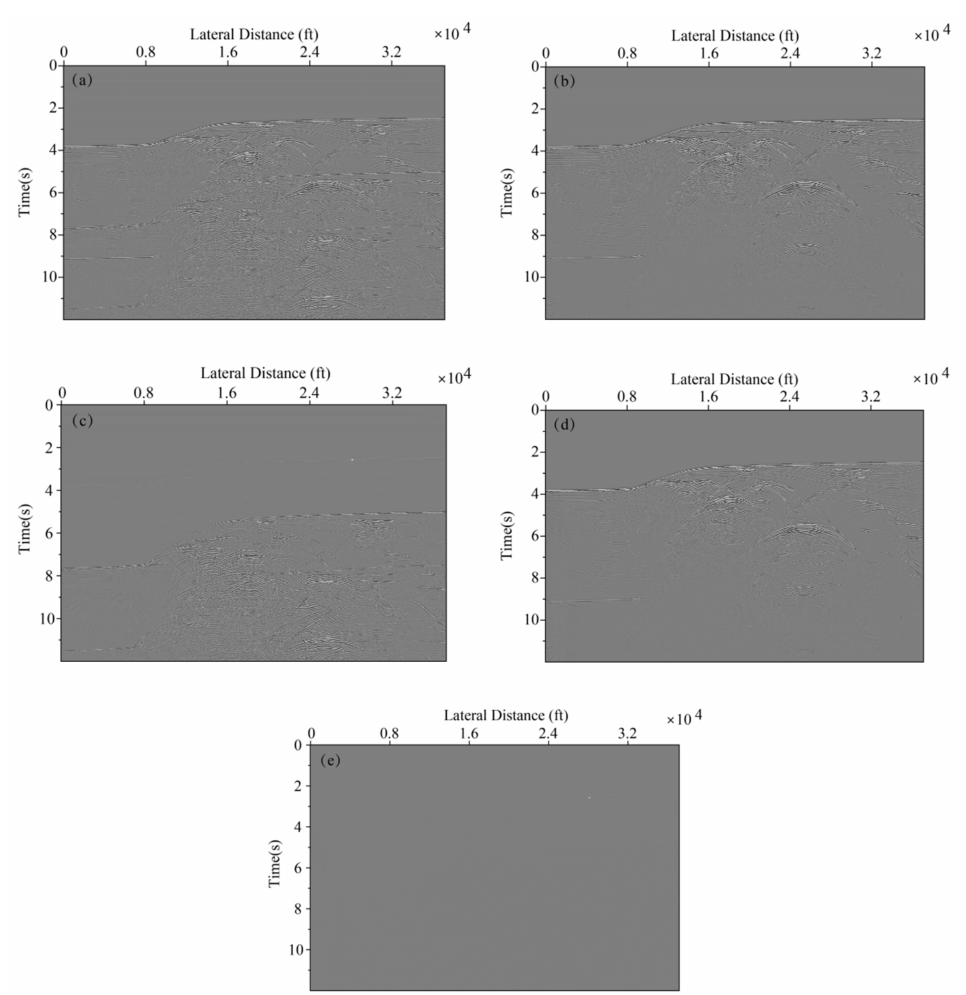
Figure 8. Zero-offset data with surface-related multiple elimination using deep learning. ( a ) Original zero-offset data with surface-related multiples. ( b ) Result after using deep learning. ( c ) The predicted internal multiples (the difference between ( a ) and ( b )). ( d ) Original zero-offset data without surface- related multiples. ( e ) The difference between ( b ) and ( d ).